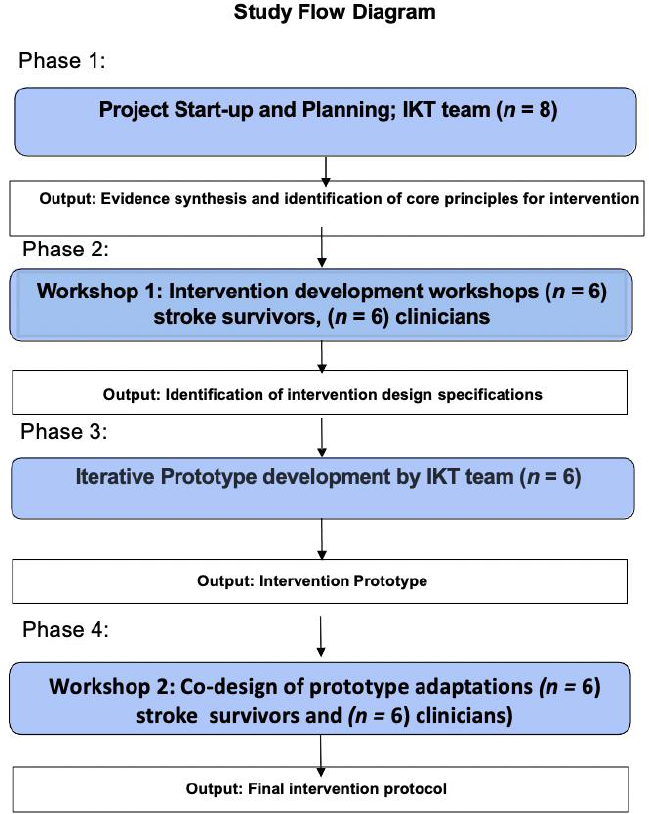
Figure 1. Flow chart of Integrated Knowledge Translation (IKT) study